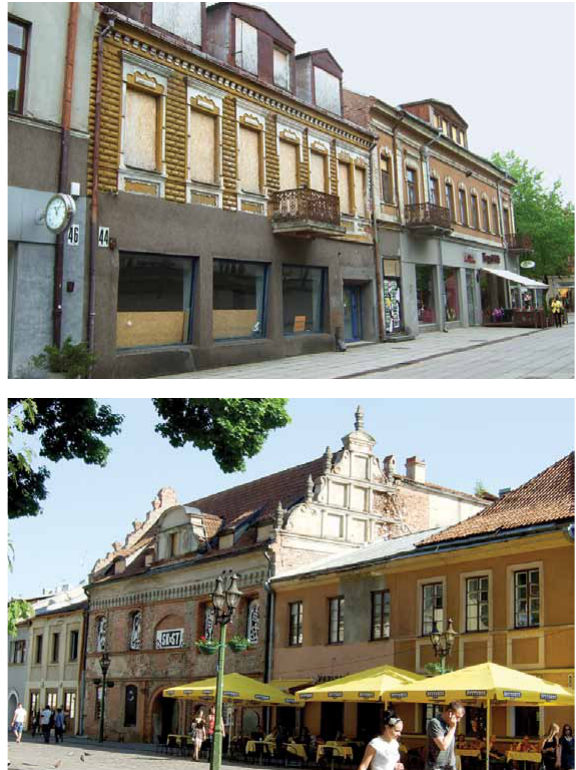
figs. 1, 2. unexploited derelict houses in Kaunas, laisves av. and Vilniaus St.